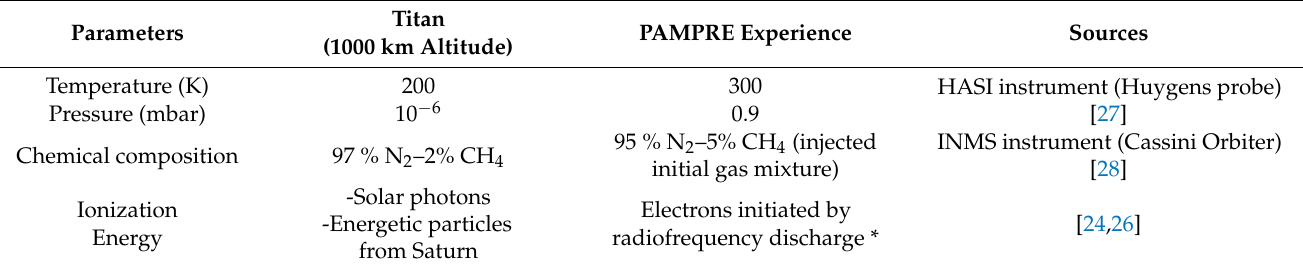
Table 1. Comparison of the environmental conditions encountered in our experiment and in Titan’s ionosphere. Titan PAMPRE Experience Sources Parameters (1000 km Altitude) Temperature (K) 200 300 HASI instrument (Huygens probe) [27]Pressure (mbar) 10 − 6 0.9 INMS instrument (Cassini Orbiter) Chemical composition 97 % N 2 –2% CH 4 initial gas mixture)